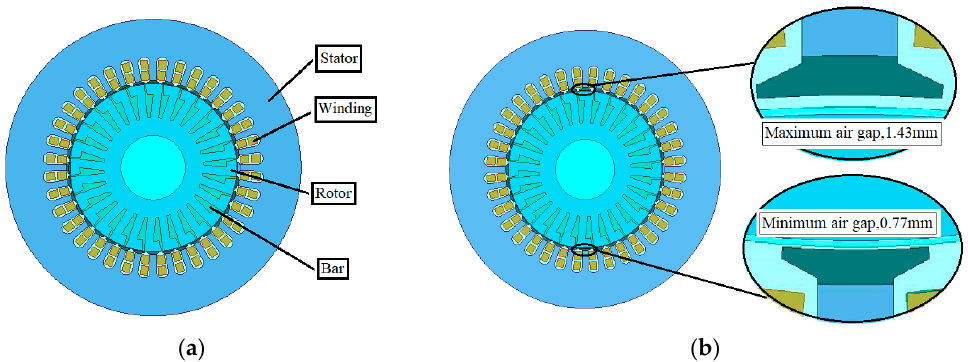
Figure 5. 2D finite element electromagnetic field simulation models: ( a ) normal operation condition; ( b ) eccentric operation condition.